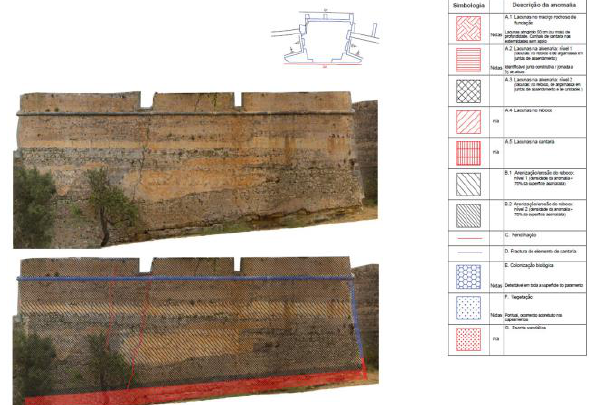
Figure 8. Example of the state of conservation' documentation of “Baluarte do